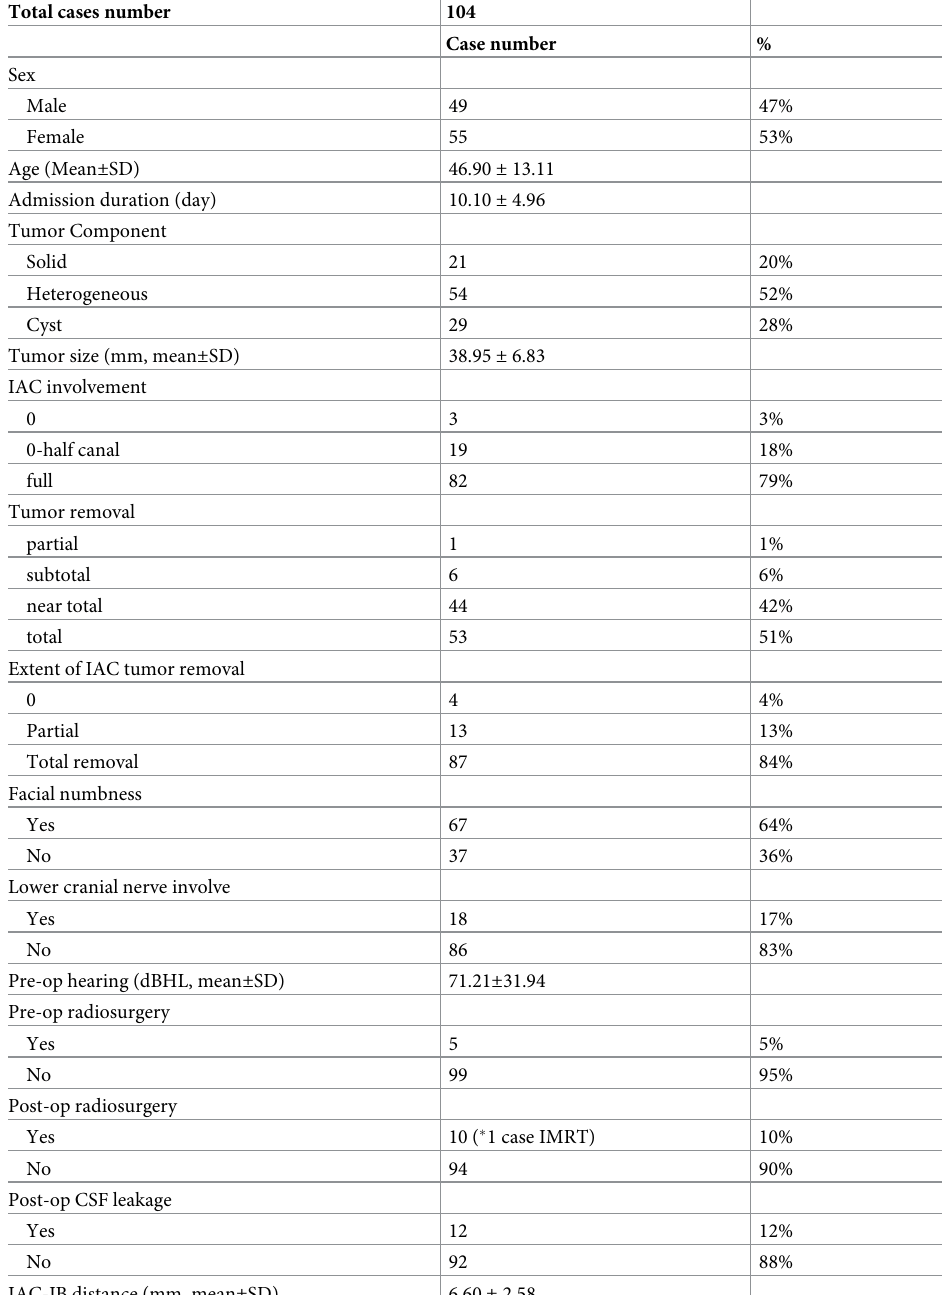
Table 1. Demographic data of patients. Total cases number